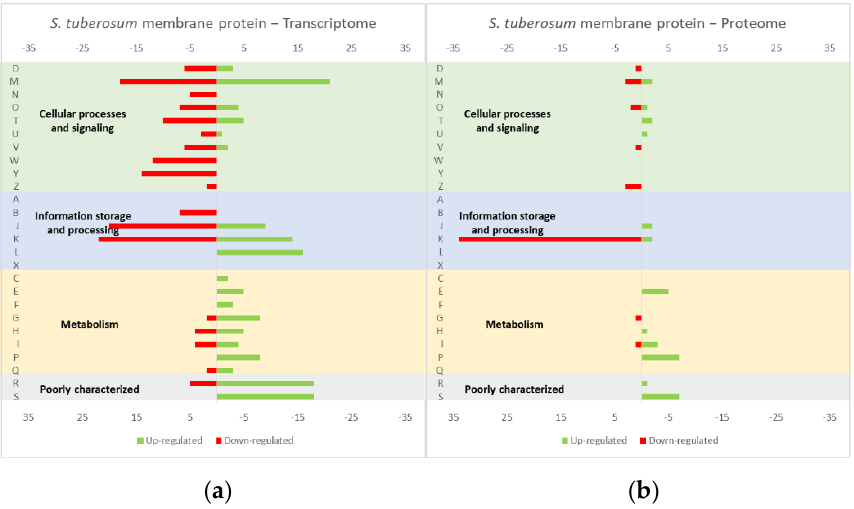
Figure 2. Effect of the StSUT1 expression in the L. lactis ( a ) transcriptome and ( b ) proteome. The graphs were constructed with compiled data from Marreddy et al. [30] and represent the total num- ber of transcripts or proteins up or down-regulated in each cellular process, when compared with the strain harboring the empty vector. The letters on the yy axis correspond to the COG categories: A, RNA processing and modification (not used for prokaryotic COGs), B, chromatin structure and dynamics, C, energy production and conversion, D, cell cycle control and mitosis, E, amino acid metabolism and transport, F, nucleotide metabolism and transport, G, carbohydrate metabolism and transport, H, coenzyme metabolism, I, lipid metabolism, J, translation, K, transcription, L, rep- lication and repair, M, cell wall/membrane/envelope biogenesis, N, Cell motility, O, post-transla- tional modification, protein turnover, chaperone functions, P, Inorganic ion transport and metabo- lism, Q, secondary metabolites biosynthesis, transport and catabolism, T, signal transduction, U, intracellular trafficking and secretion, Y, nuclear structure (not applicable to prokaryotic COGs), Z, cytoskeleton (not applicable to prokaryotic COGs); R, general functional prediction only (typically, prediction of biochemical activity), S, function unknown [35,36].